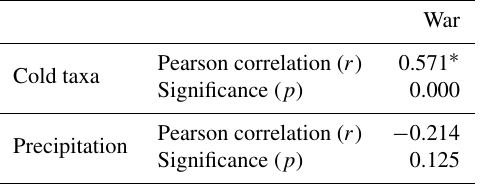
Table 1. Results of Pearson correlation analysis of cold-preferring chironomid taxa percentages and reconstructed precipitation to the incidence of